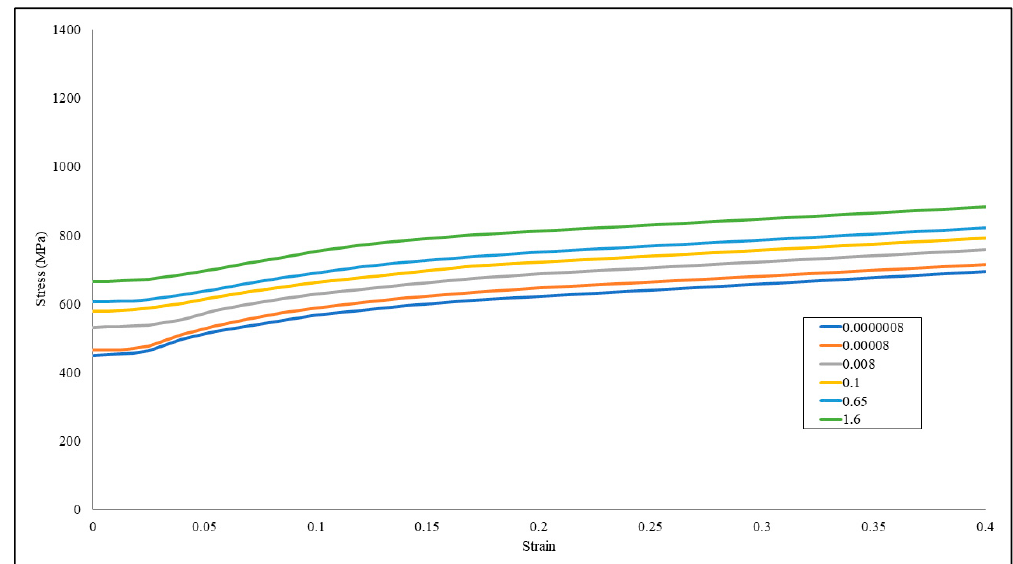
− 1 . Energies 2020 , 13 , x FOR PEER REVIEW